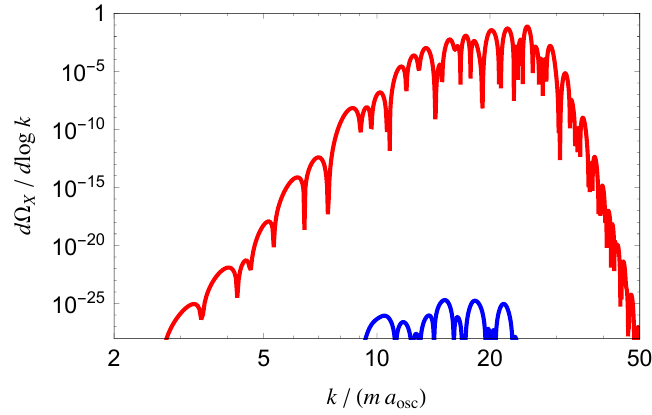
Figure 1 . Dark photon spectral energy density when the tachyonic band has closed for model parameters m = 10 meV, f = 10 17 GeV, (cid:11) = 55, and (cid:18) = 1 : 2. The red line corresponds to the spectrum for \+ 00 helicity dark photons while the blue line gives the \ (cid:0) 00 helicity